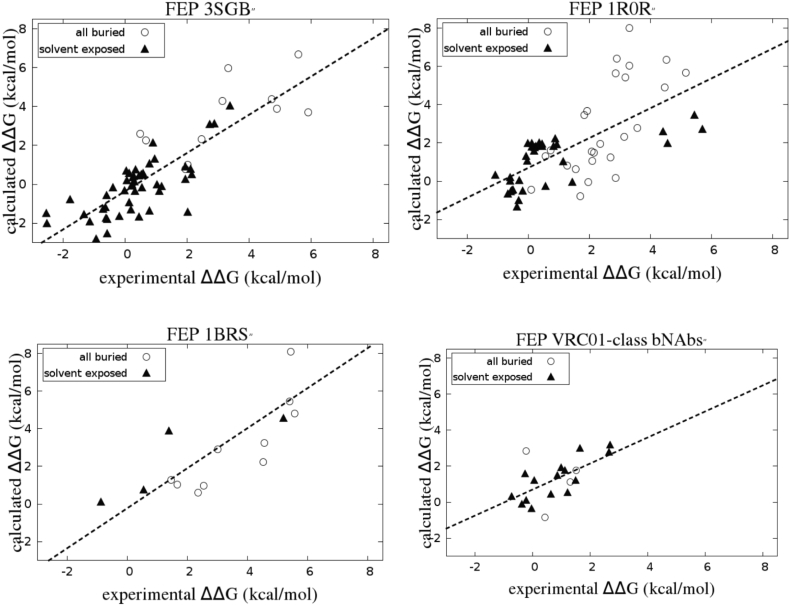
FEP results by system considered; results for the three VRC-01 class antibodies are combined.